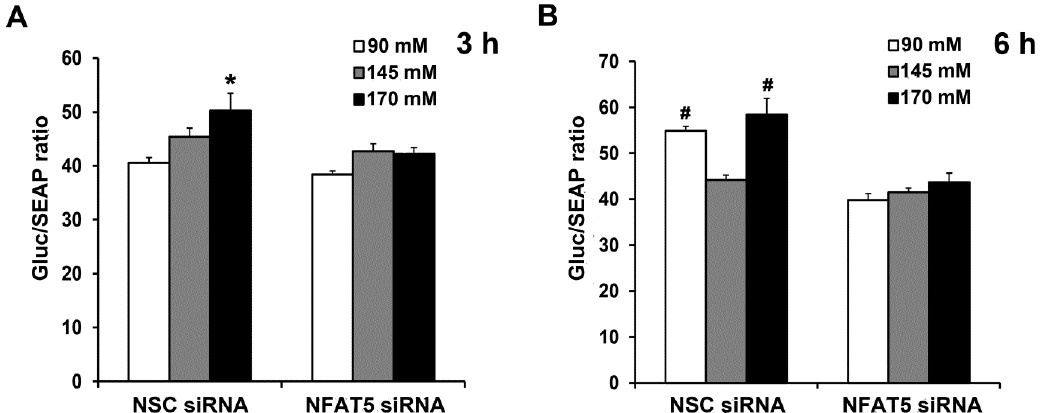
Figure 6. Sodium-induced increase in NFAT5 expression occurs via the GRPR promoter. The same quantity of human L-cells was co-transfected with the NFAT5 siRNA or non-silencing (NSC) siRNA and promoter reporter clone for human GRPR. After 48 h, the cells were exposed to fresh medium with varying concentrations NaCl. Gluc ( Gaussia luciferease ) and SEAP (Secreted Alkaline Phosphatase) activities were determined using Secrete-Pair Dual Luminescence Assay Kit at 3 h ( A ) and 6 h ( B ). Results were normalized with corresponding SEAP activity. n = 3/group. * p < 0.05 vs. others. # p < 0.05 vs. NSC siRNA 145 mM or NFAT5 siRNA. One-way ANOVA, Holm–Sidak test.